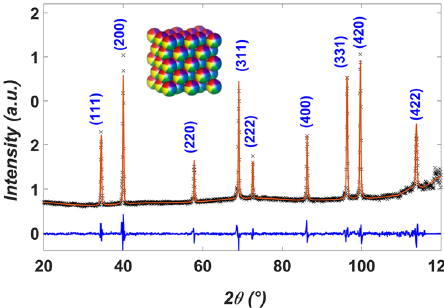
Fig. 2 | Generalized VibrationalDensityofStates(GVDOS) ofsingle-crystaland polycrystalline samples of the HEA FeCoCrMnNi. a GVDOS measured on the polycrystalline sampleat IN6-SHARP@ILLwith anincident neutron wavelength λ = 5.1 Å atthreetemperatures,resultingina Q rangeof0-2.1 Å − 1 at S ( Q , E =0). b GVDOS measuredonthesinglecrystallinesampleonIN5@ILLwithaneutronwavelength λ = 3.2 Å , resulting in a Q range of 0-3.6 Å − 1 at S ( Q , E =0), compared to that of the singleelementNi 46 and the binary alloyNiFe 46 .Insets reportthe linearand squared dependencies ( fi ts in black dashed lines) of FeCoCrMnNi in a and b at 300K,